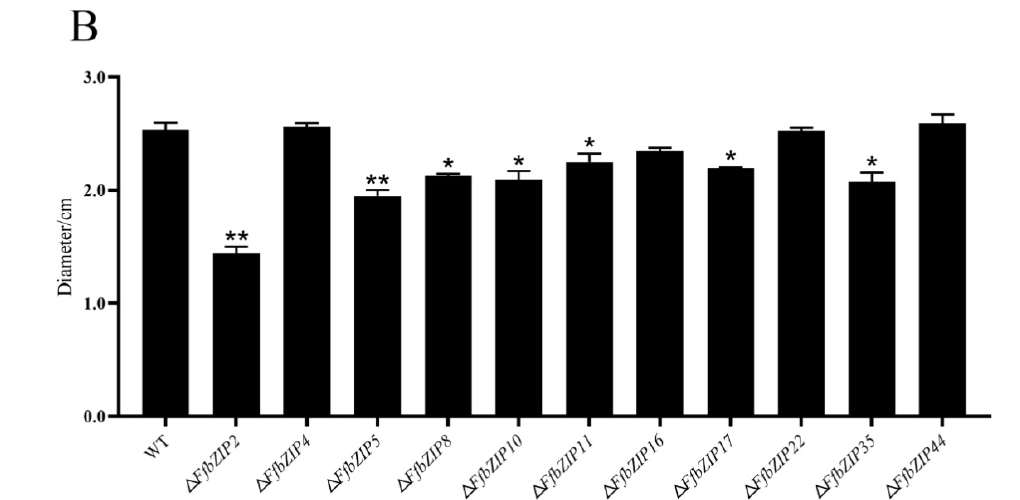
Figure 8. Cellulose utilization experiment. ( A ) Growth of wild type and FfbZIP knockout mutants in Cellulose Congo red medium. ( B ) Histogram of strain diameter under cellulose Congo red culture conditions. Error bars represent means ± SEs. * p < 0.05, ** p < 0.01.